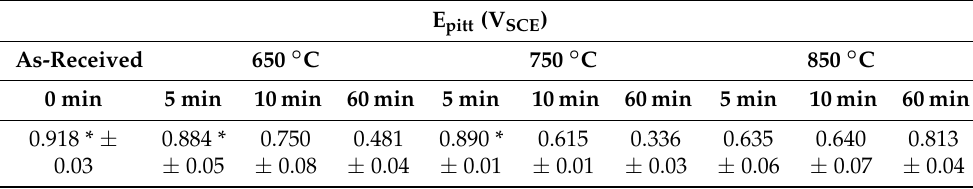
Table 2. Average E pitt values with standard deviation evaluated in 1 M NaCl solution at 20 °C on both as-received and aged DSS 2304 electrodes.